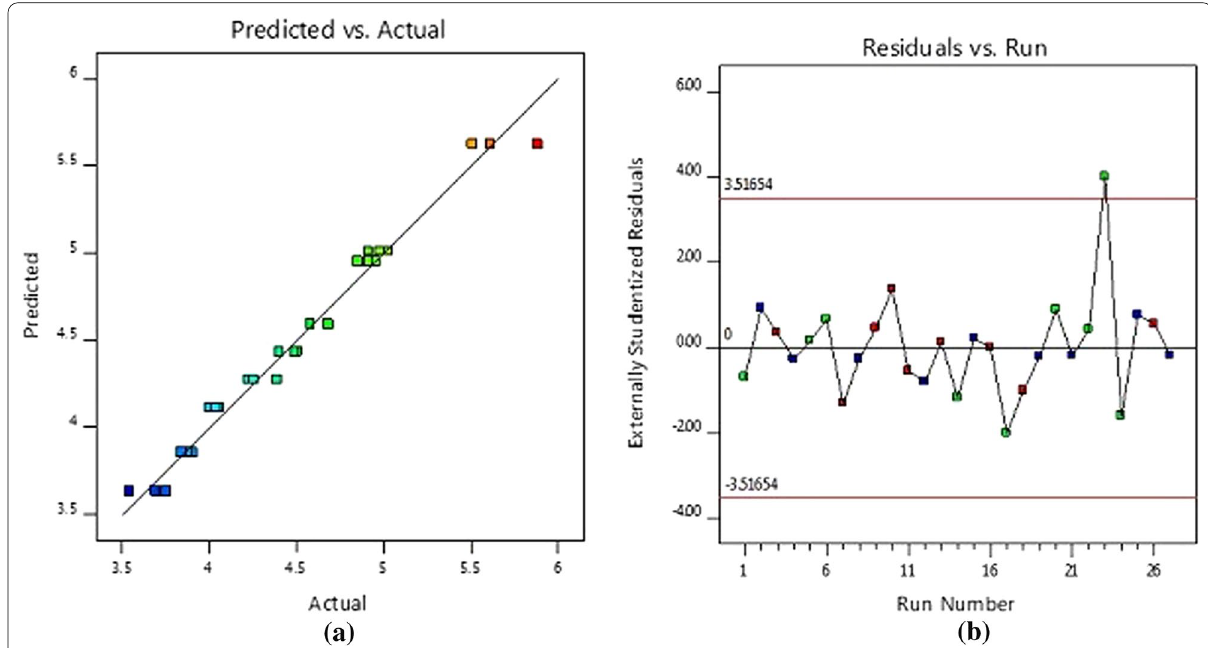
Fig. 4 Plot a showing values true verses predicted with the residual plot b for the response